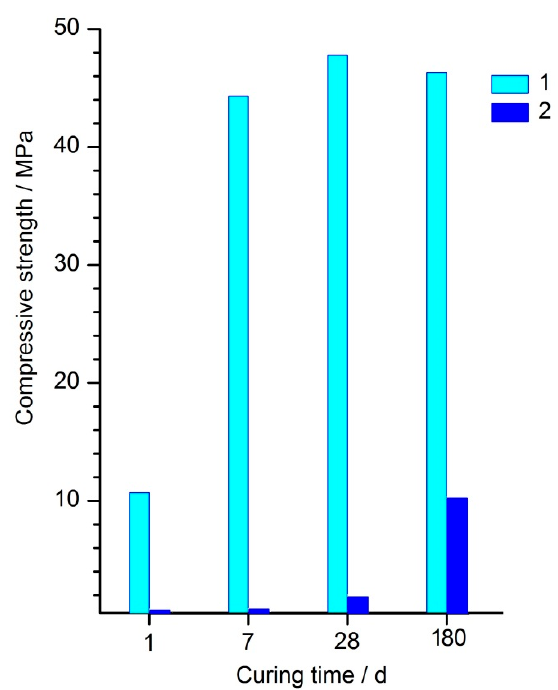
Figure 10. Variation of the compressive strength in terms of curing time for the binder prepared using the (50% nepheline concentrate + 50% gypsum) mixture milled for 270 s and cured at 20–22 °C. Curing conditions: 1—a relative humidity of 60–70%, 2—a relative humidity of 95–100%.